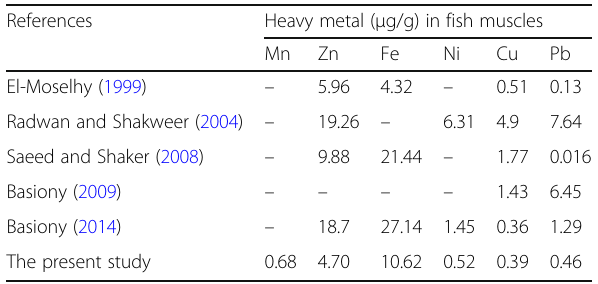
Table 13 Comparison of heavy metal values in muscles of O . niloticus fish with previous studies in northern lakes and